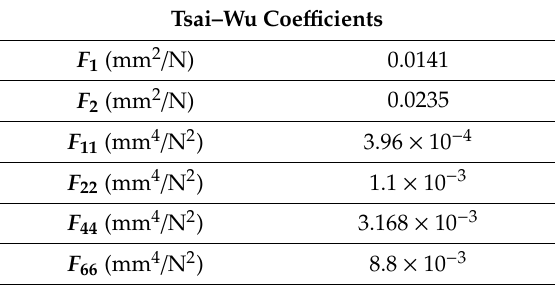
Table 3. Tsai–Wu coe ffi cients for cortical